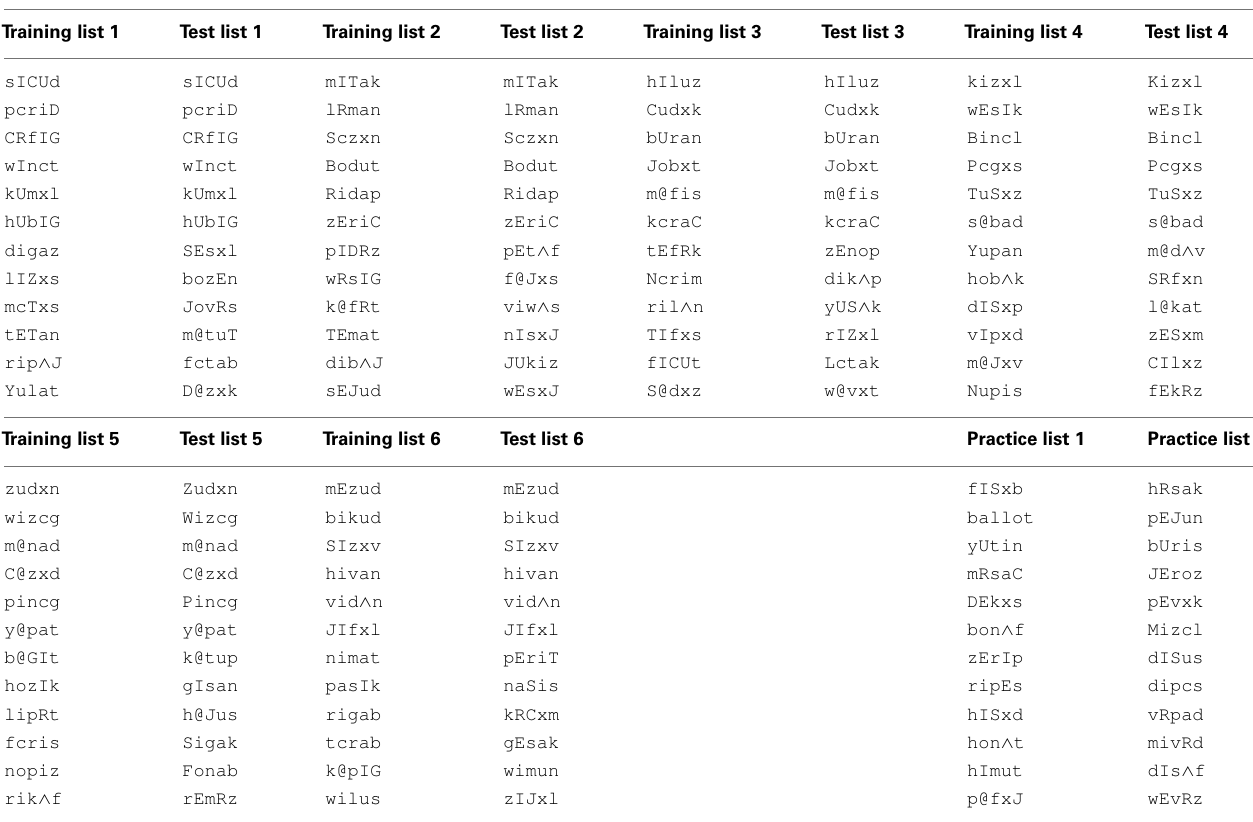
Table 3 |Word lists for paired-associates task. Lists 1–4 were used in Experiment